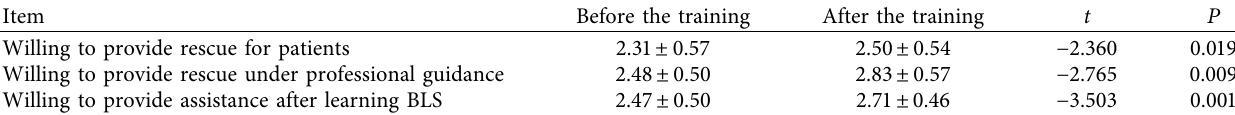
Table 3: Comparison of BLS attitude scores of community residents before and after training ( x ± s , scores). Item